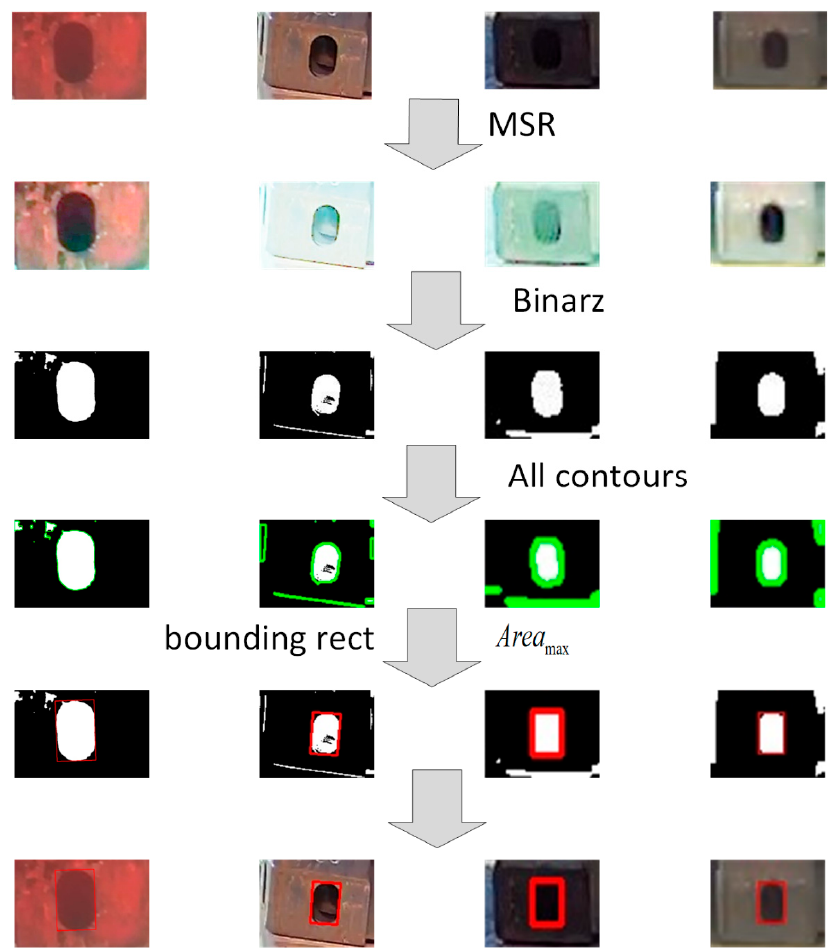
Figure 18. Secondary positioning results. The first row shows the input image after the above detection and tracking. The second row shows the results after MSR image enhancement. The third row shows the results after binarization. The fourth row shows all the contour results in the marked image. The fifth row shows the result of fitting the largest contour using the smallest rectangle. The sixth row shows the result after secondary positioning.